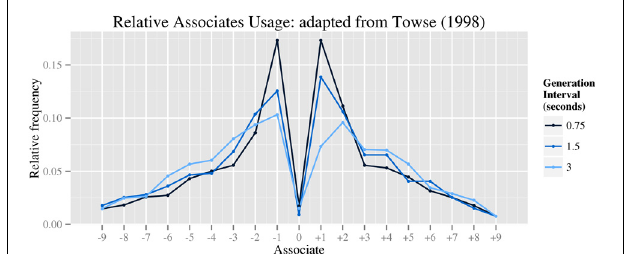
FIGURE 2 | Distribution of difference scores—the difference between consecutive responses (adapted from Towse, 1998, Figure 2).